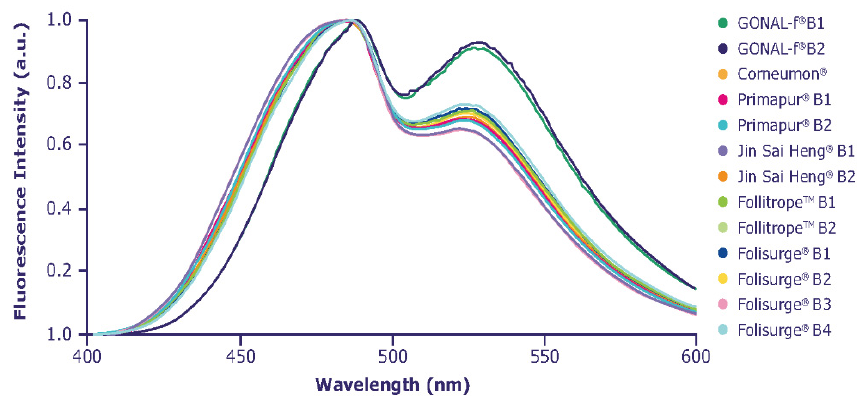
Figure 5. Extrinsic fluorescence spectroscopy profile.